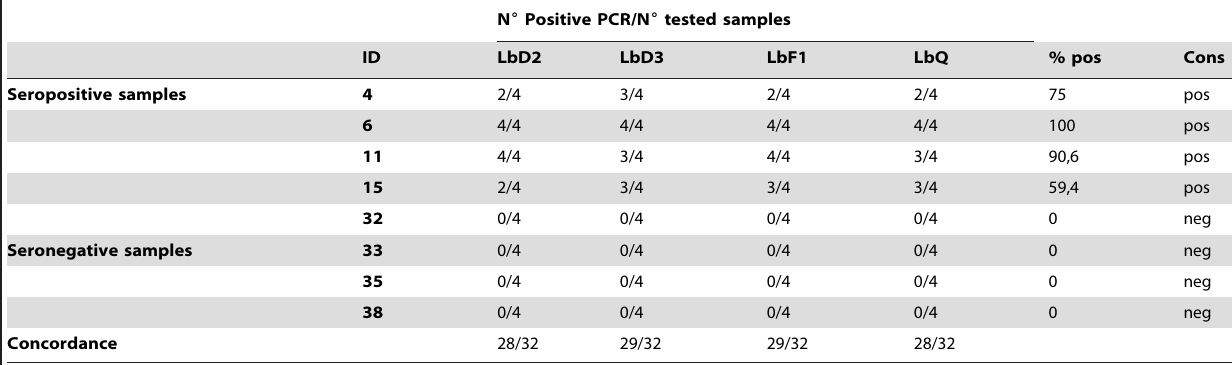
Table 5. Intra-laboratory evaluation of best performing methods in human samples.